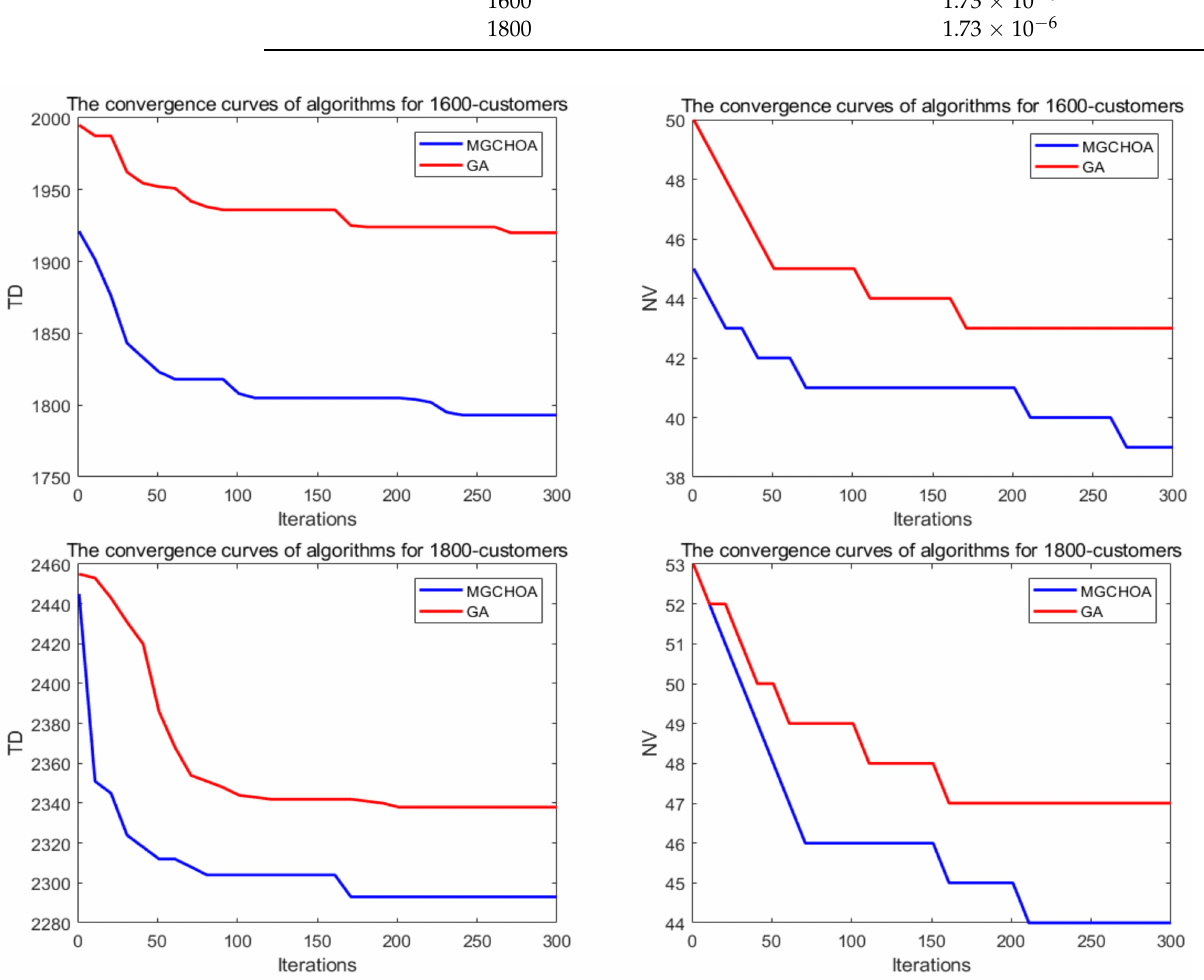
Figure 18. The convergence curves after 300 iterations of the